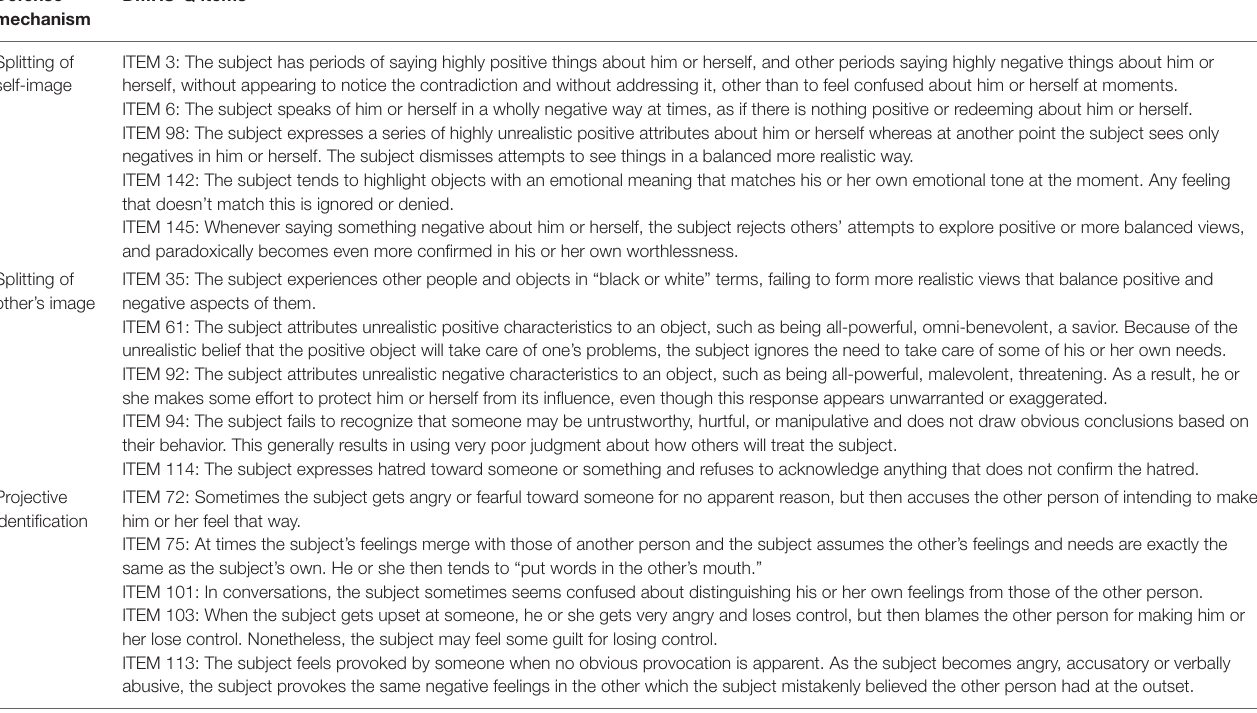
TABLE 7 | Major image-distorting defense level: Definition, function and DMRS-Q items of defenses splitting of self-image, splitting of other’s image, and projective identification. Defense